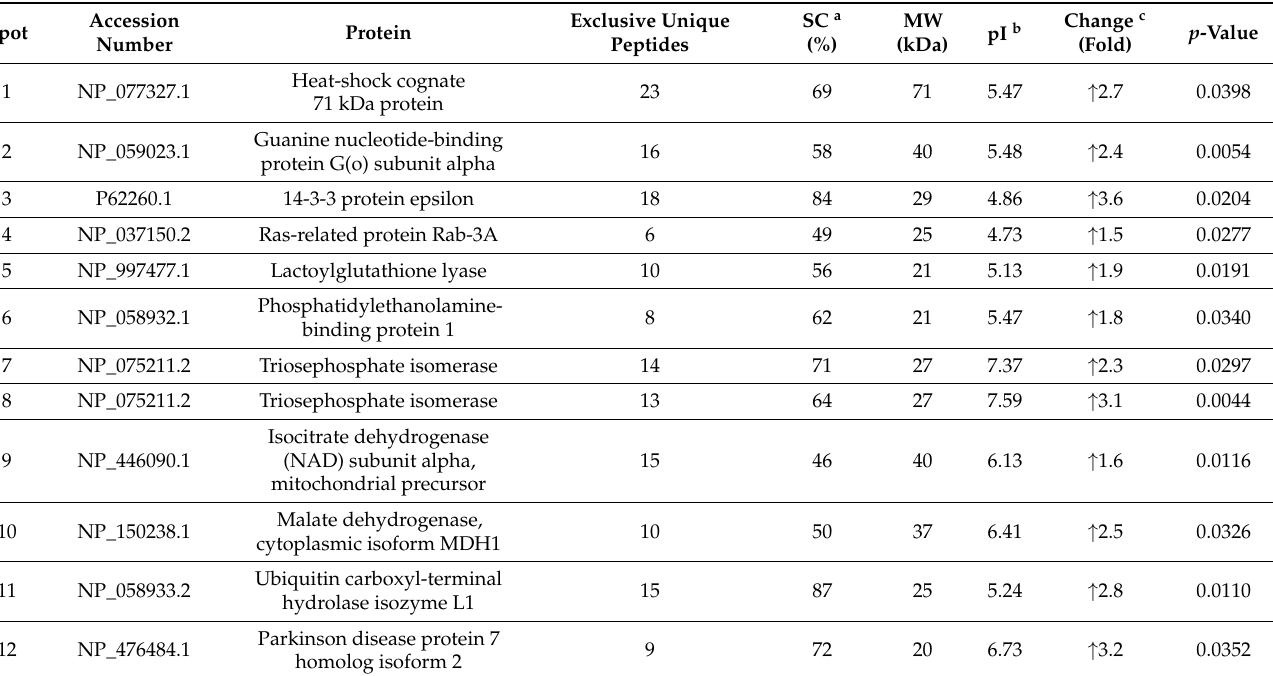
Table 1. LC–MS/MS analysis of altered protein spots in PNS fractions isolated from mPFC of SNL versus sham-operated rats 2 weeks after the surgery. The complete list of exclusive unique peptides is presented in Table S1.